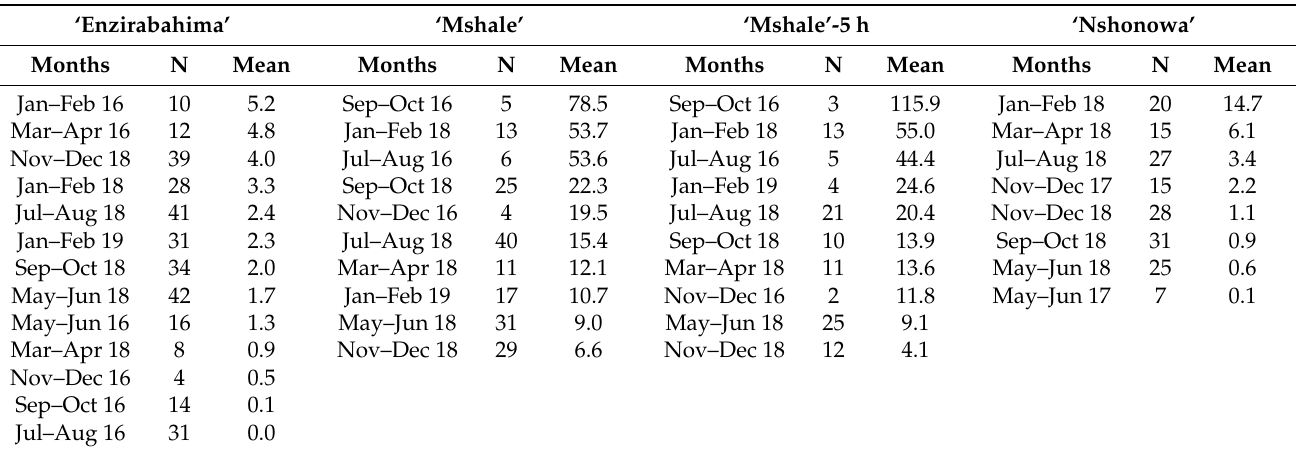
Table 5. Predicted bi-monthly mean seed set per 100 fruits in East African Highland Cooking bananas after pollination with and without pollen germination media (30 g/L glucose and complete media).